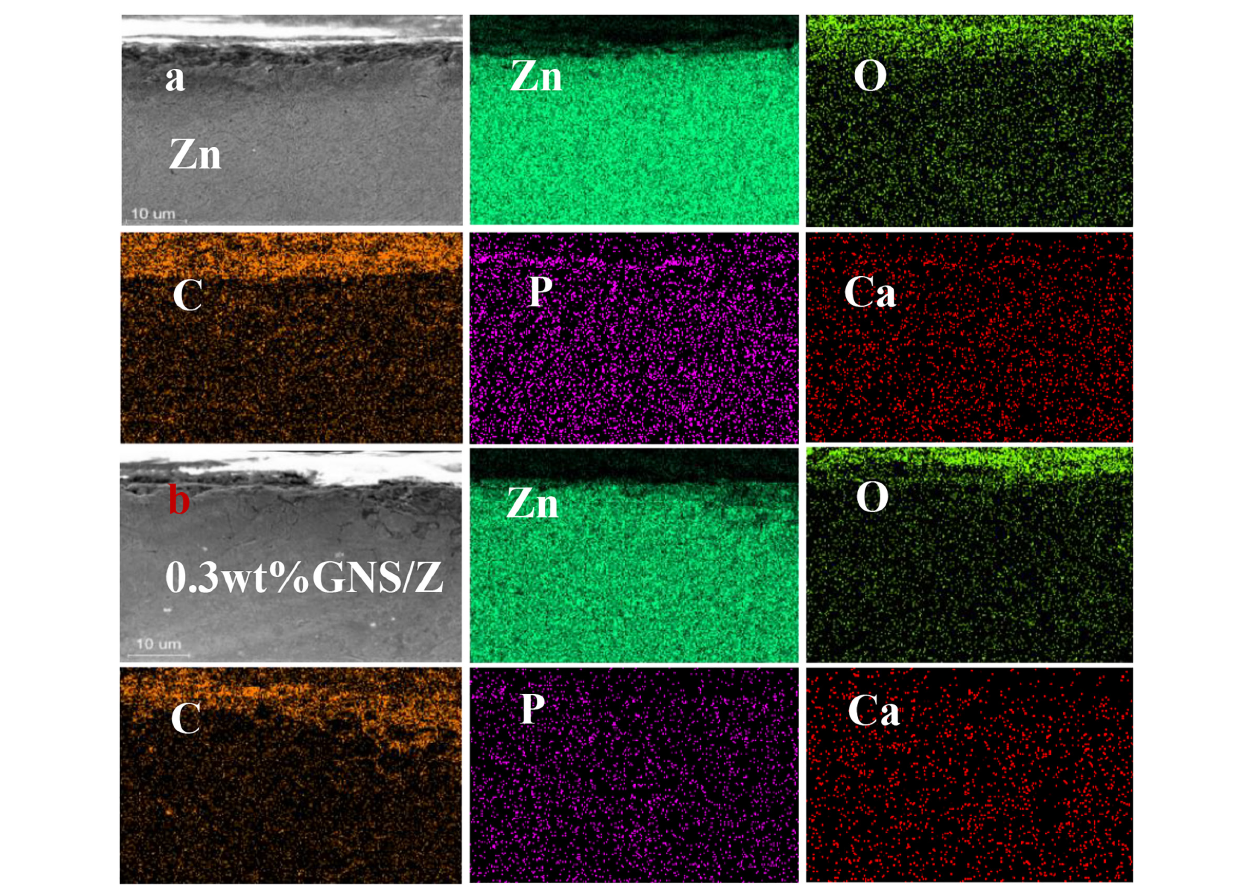
FIGURE 12 | (a) EDS profile after immersion in pure Zn. (b) EDS profile of 0.3 wt% GNS/Zn composites.